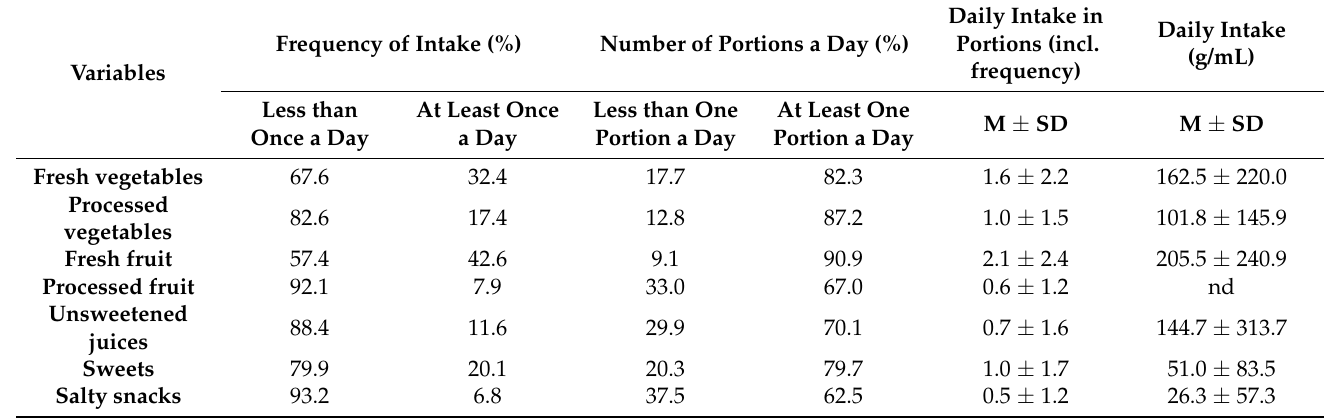
Table 7. Food intake in the study